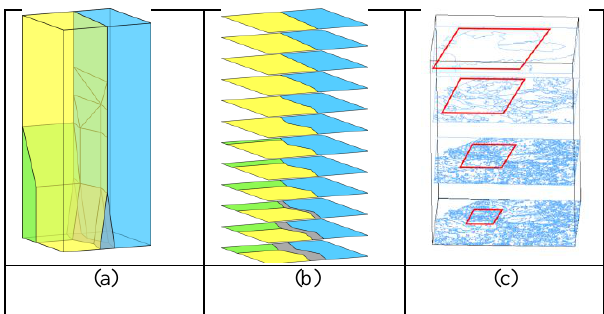
Figure 1. Examples of integrating the 1D scale dimension and 2D space into a 3D structure. (a) Every map object, 4 in this case, is represented as one polyhedron. (b) Maps are slices (cross sections) of this 3D model. (c) For interactive use, apart from taking a slice, also a bounding box filter should be